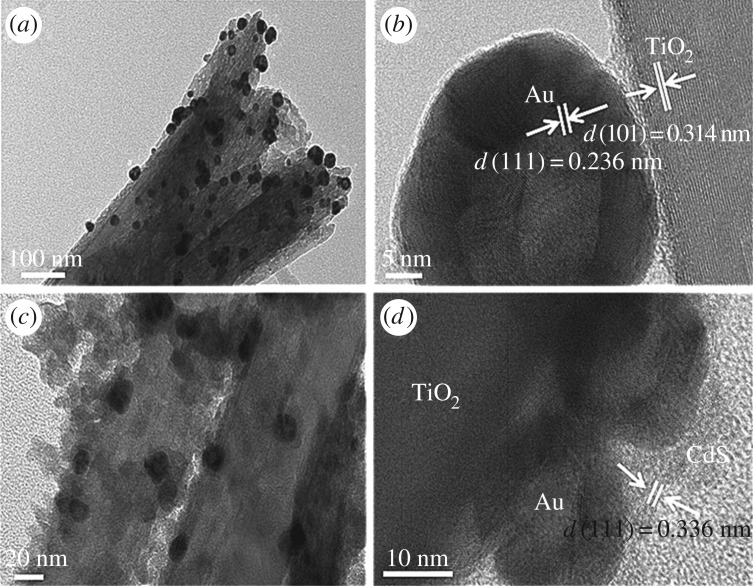
TEM images of (a) TiO2NR/HGN and (c) TiO2NR/HGN/CdS hybrids. High-resolution TEM images of (b) TiO2NR/HGN and (d) TiO2NR/HGN/CdS hybrids.